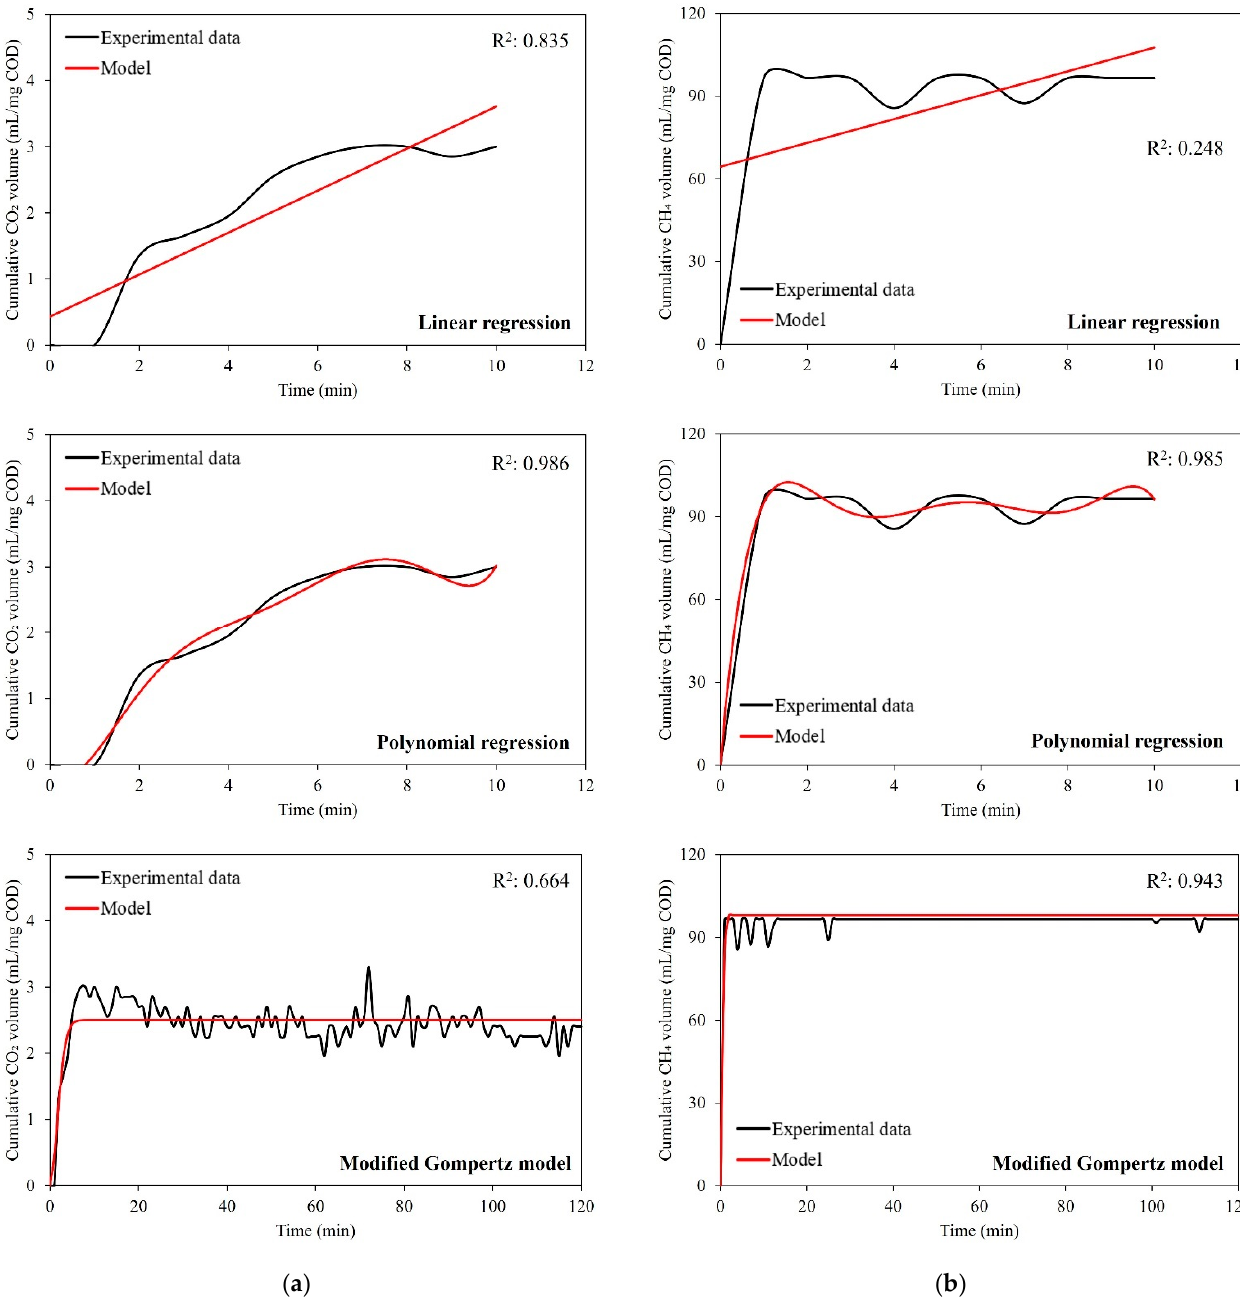
Figure 3. Simulated and experimental data of cumulative biogas volume of ( a ) CO 2 and ( b ) CH 4 from POME assisted by DBD treatment under the aerated conditions at a discharge voltage of 25 kV.